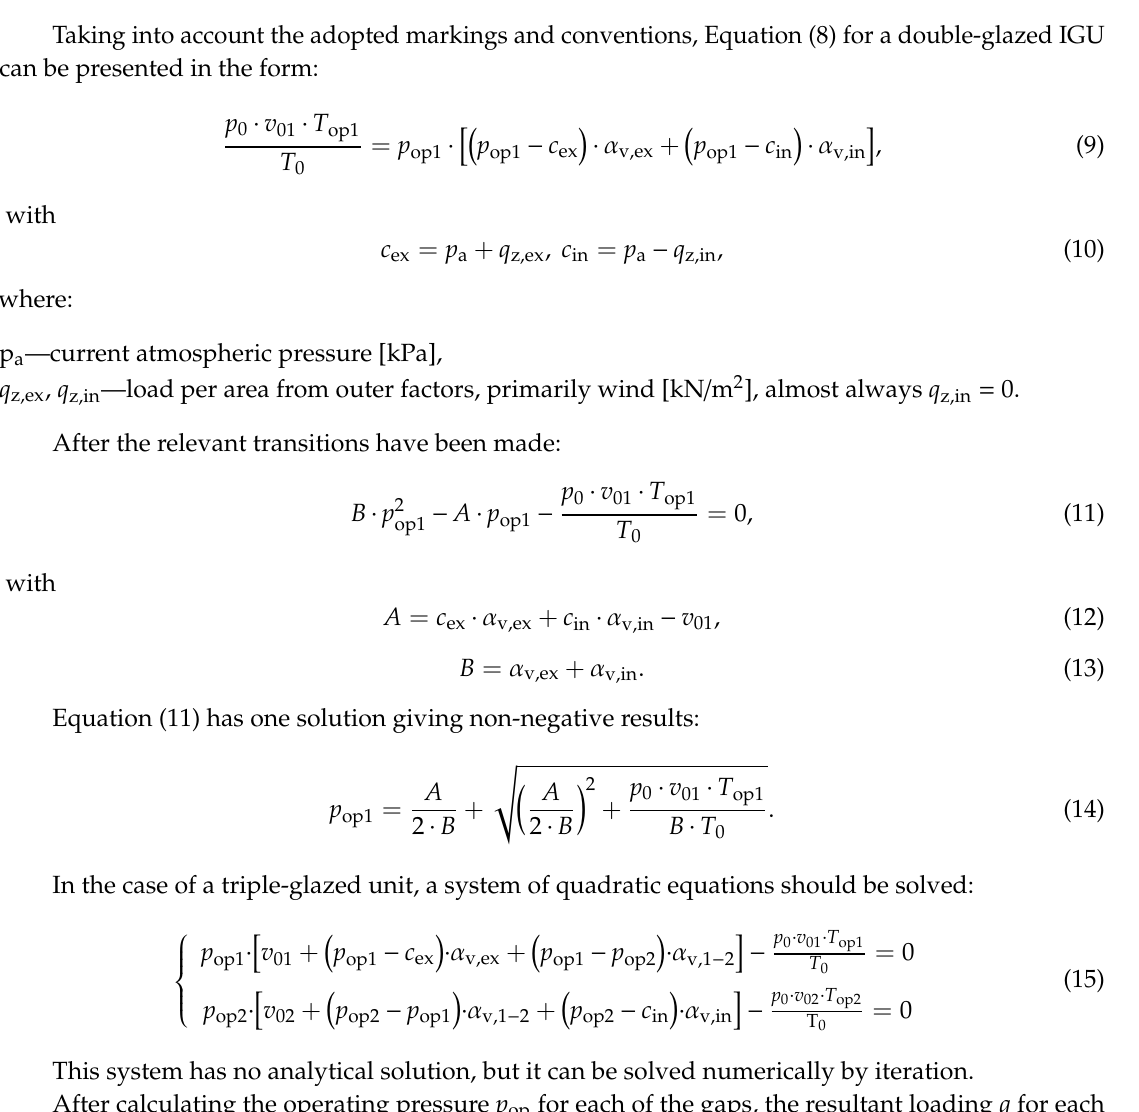
Figure 3. Index designations of IGU elements and location of low-emission coatings (dashed line): ( a ) double-glazed IGU, ( b ) triple-glazed IGU.